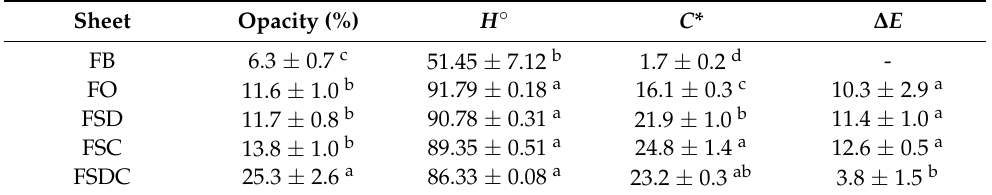
Table 2. Color parameters of the control sheet (FB) and sheets added with tucum ã oil (FO) and microparticles produced by varying techniques (FSD, FSC and FSDC), as well as the total color difference of sheets after storage a room temperature for 60